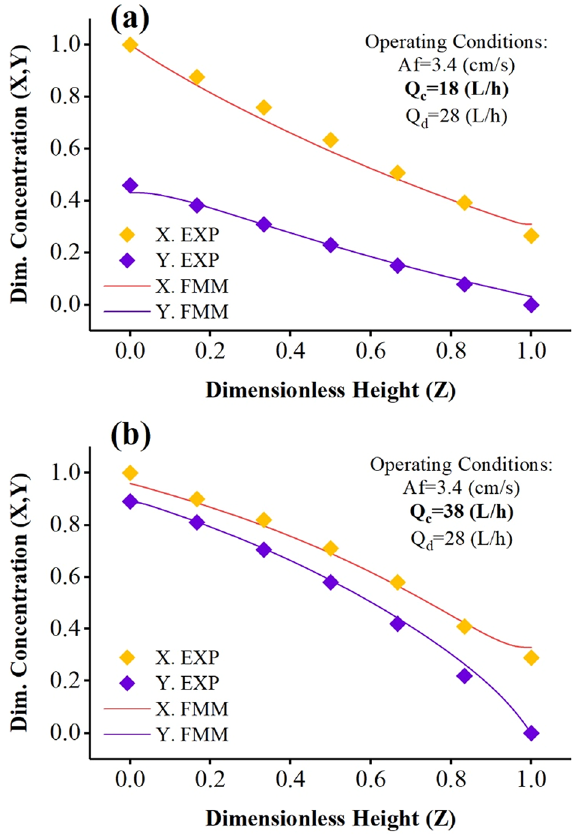
Figure 4. Comparison of laboratory concentration profiles with predicted by the forward mixing model under Q d = 28 (L/h) and Af = 3.4 (cm/s) and ( a ) Q c = 18 and ( b ) Q c = 38